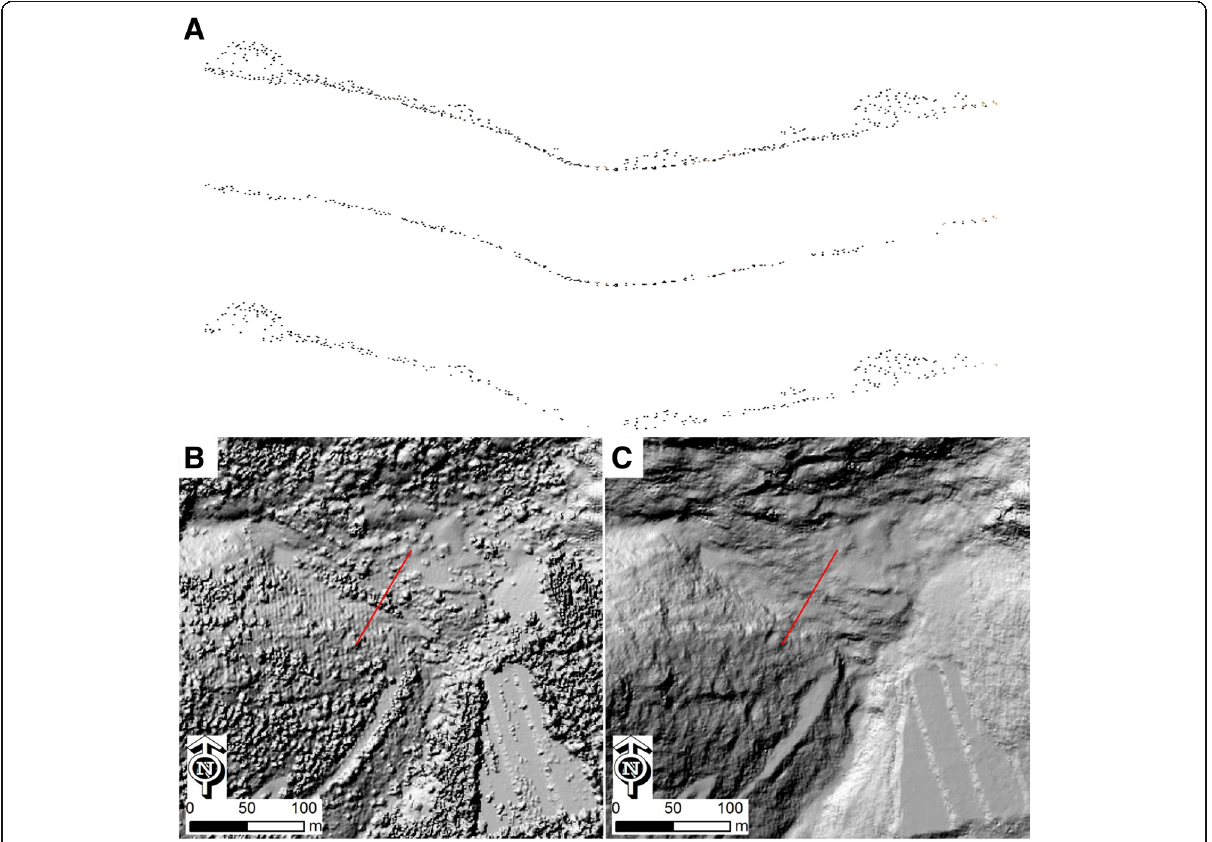
Fig. 1 Effect of vegetation cover on ALS data (National Geographic Institute, Government of Spain) corresponding to the case study area in “ La Pedriza ” (Madrid, Spain). a Elevation profile from ALS considering all the ALS points (up), only the points classified as terrain (middle), and only the points classified as vegetation (bottom). The number of ALS points giving information on the terrain surface decreases in the areas with more vegetation. Effect of vegetation on a DEM considering all the ALS points ( b ) and only the points classified as terrain surface ( c ). The red line corresponds to topographic profiles in ( a